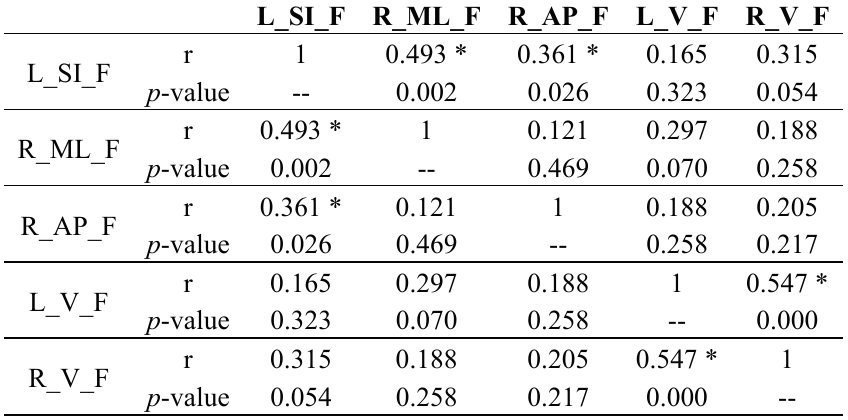
Table 5. Spearman correlation coefficients among the select features. Significant results are indicated with an asterisk